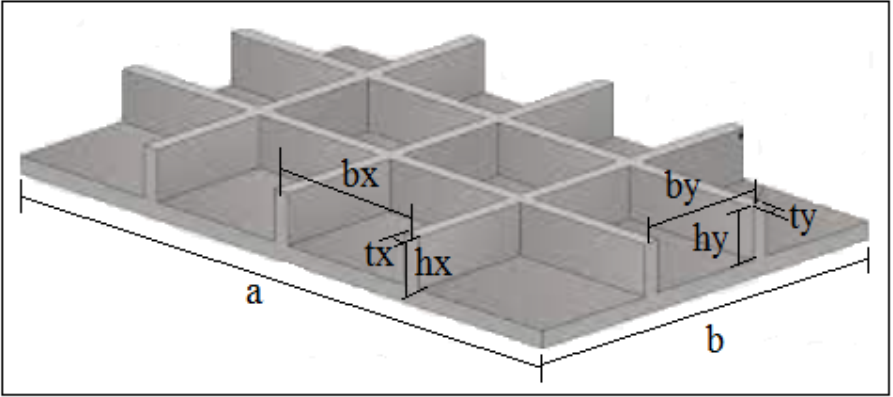
Figure 1. Loading and boundary condition of rectangular plate.